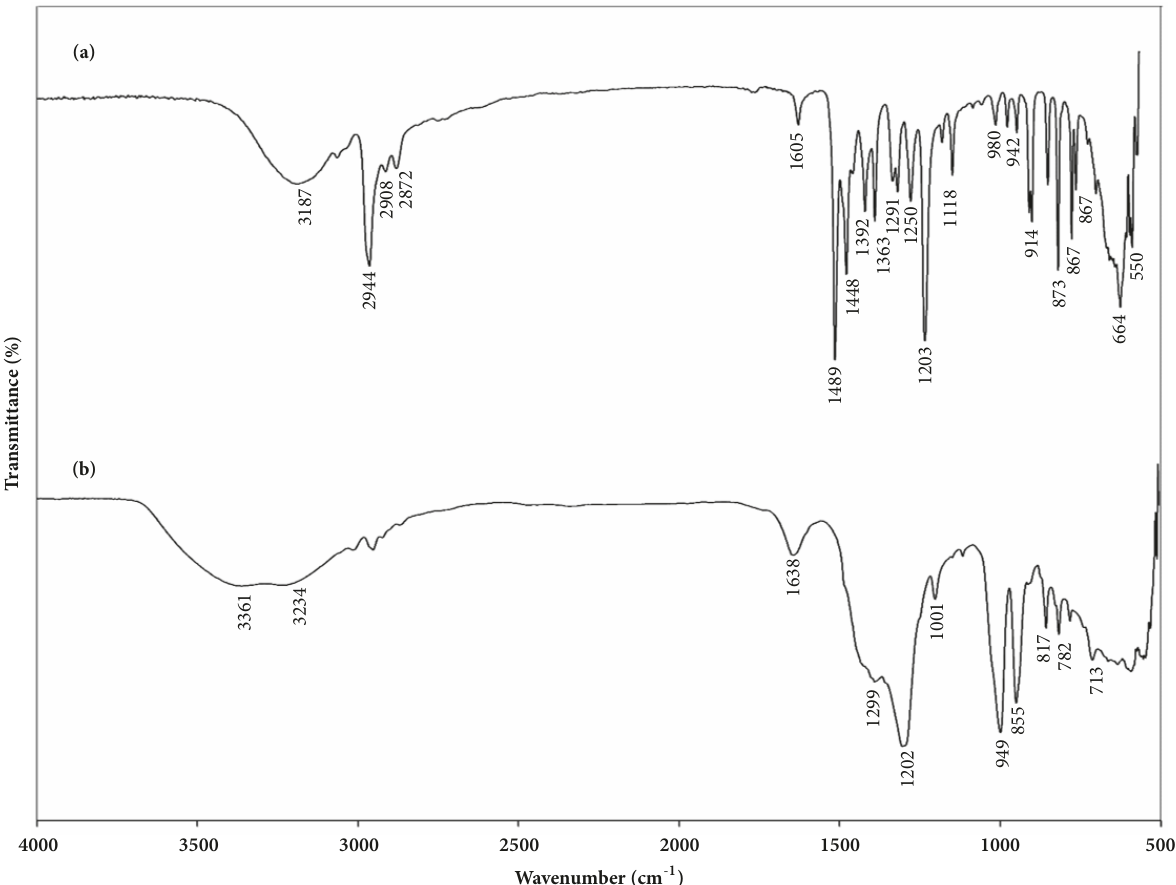
Figure 9: FTIR spectra of (a) H 8 L and (b) Cd 2+ -H 8 L.